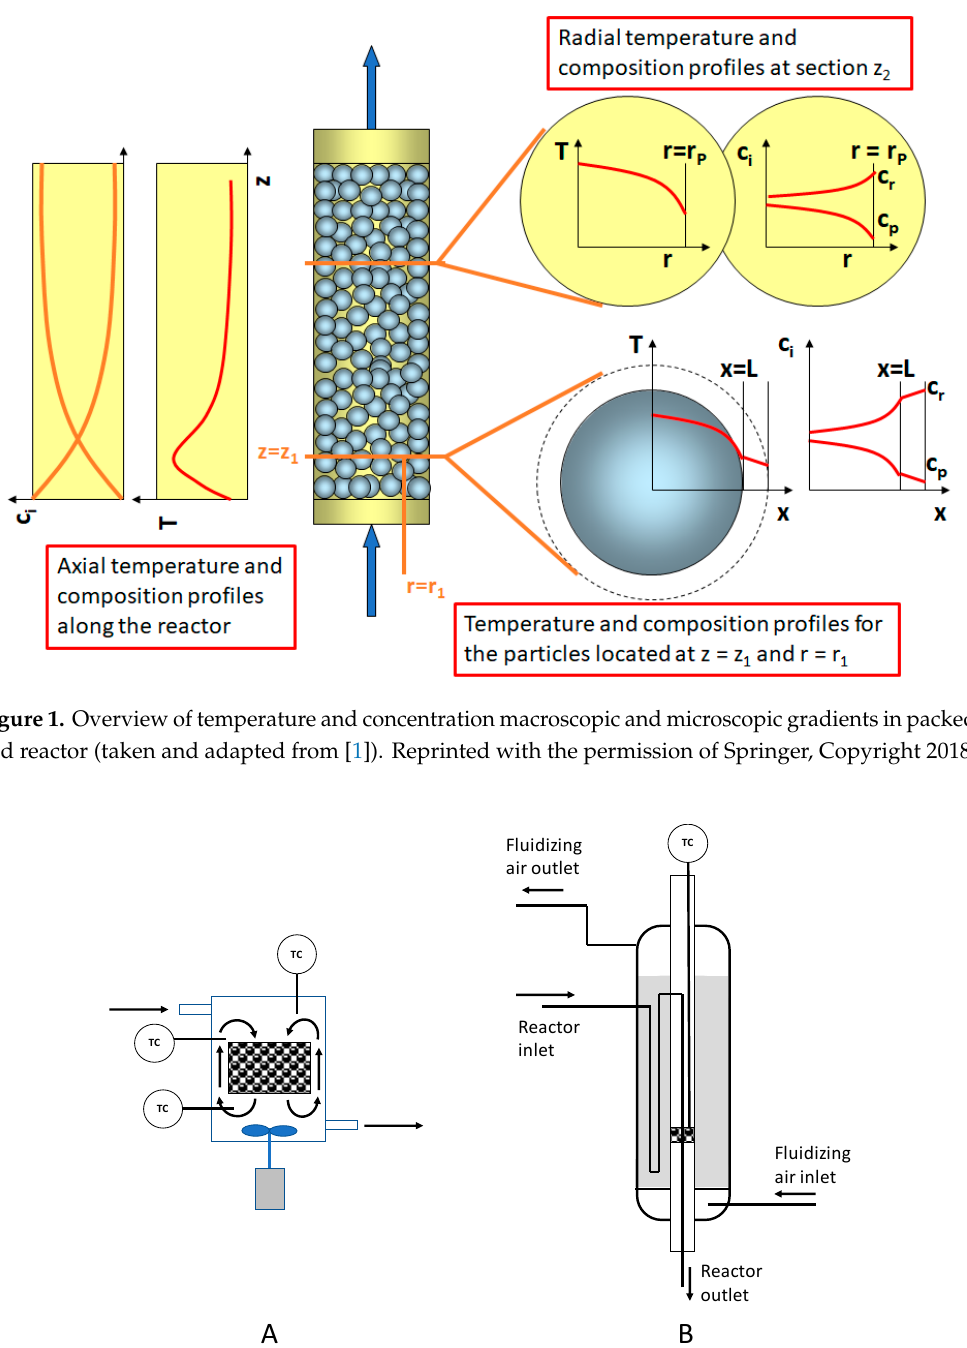
Figure 2. Examples of “gradientless” laboratory reactors. ( A ) Continuous stirred tank reactor (CSTR); ( B ) fixed-bed reactor.